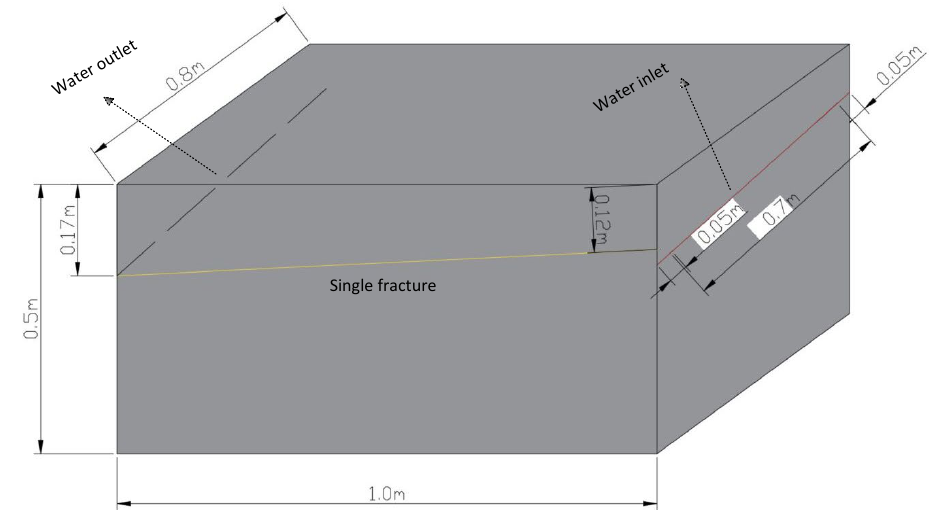
Figure 3. Specifications of the experimental rock mass with one horizontal fracture.